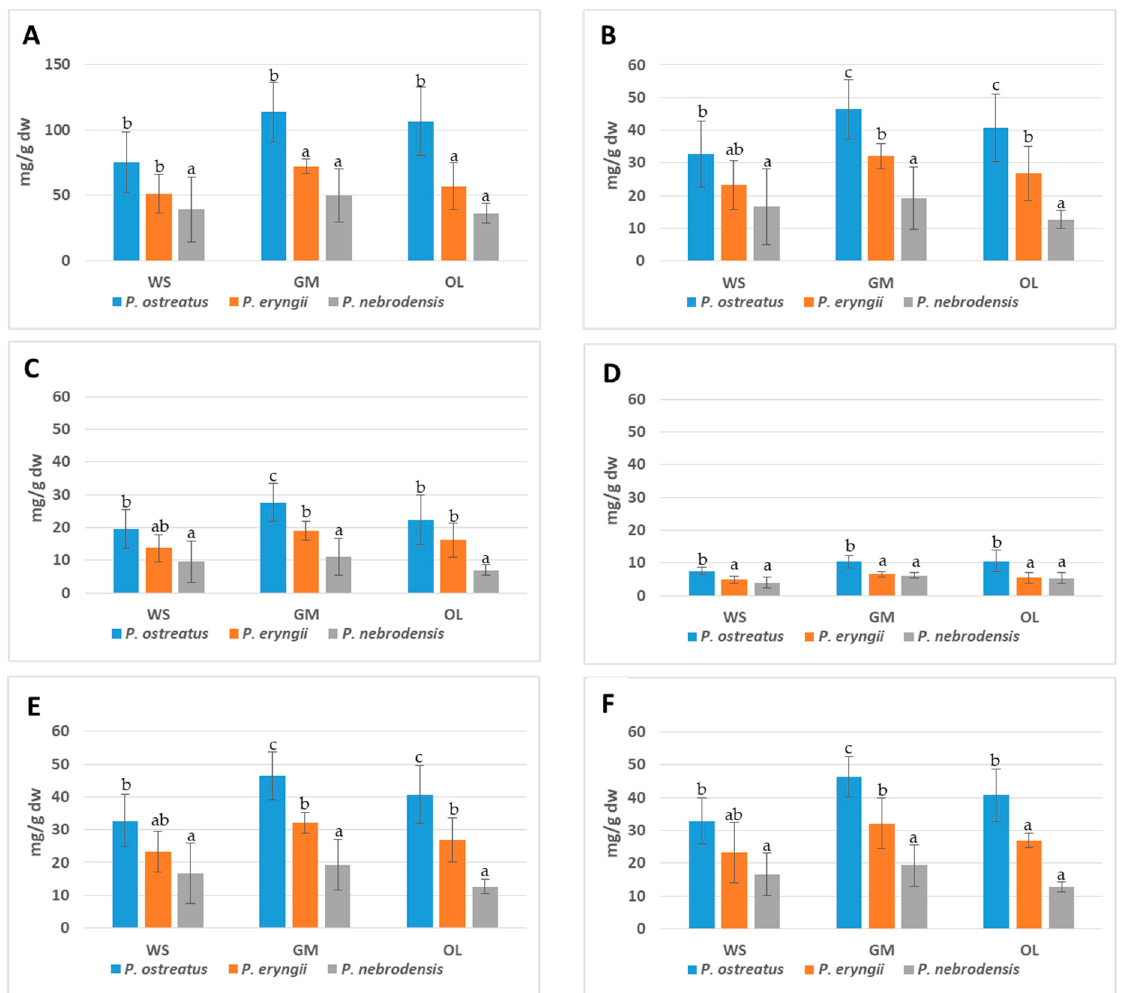
Figure 1. Total and individual groups of free amino acids in Pleurotus mushrooms, compared by species in each substrate. ( A ) Total Amino Acids, ( B ) Essential Amino Acids, ( C ) Branched Chain Amino Acids; ( D ) Monosodium Glutamate (MSG)-like Amino Acids, ( E ) Bitter Taste Amino Acids, ( F ) Sweet Taste Amino Acids. Lack of letters in common denotes statistically significant di ff erences in comparisons among species in each substrate by Duncan’s multiple comparison test at p < 0.05. Essential amino acids, Thr + Val + Met + Ile + Leu + Phe + Lys + His + Trp; BCAA Branched chain amino acids, Val + Ile + Leu; MSG-like, monosodium glutamate-like, Asp + Glu; Bitter, Val + Met + Ile + Leu + Phe + His + Trp; Sweet, Thr + Ser + Gly + Ala +